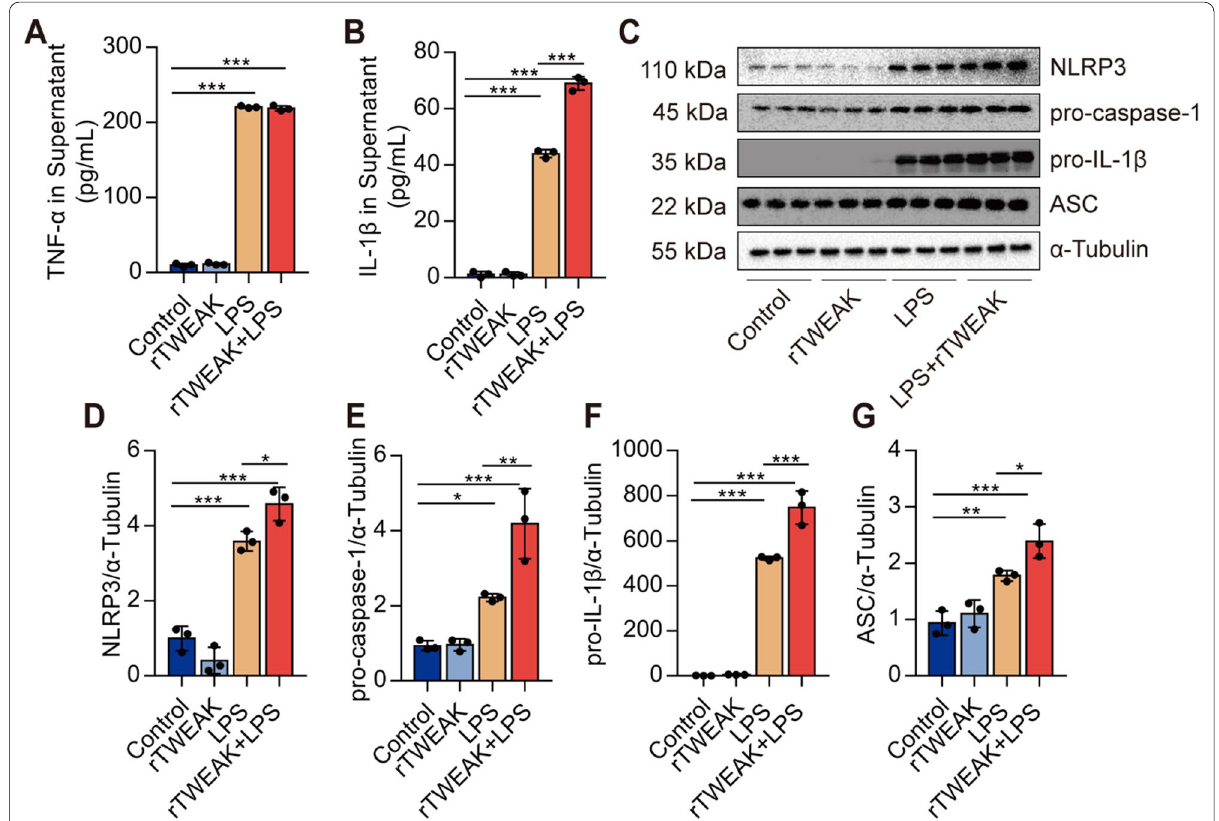
Fig. 6 Activation of Fn14 by rTWEAK promotes the priming of NLRP3 inflammasome in macrophages. rTWEAK (100 ng/mL) was added to LPS (100 ng/mL)‑challenged primary macrophages for 12 h. A , B The contents of TNF‑α and IL‑1β in the supernatant of primary macrophages were determined ( n 3). C – G The expressions of NLRP3, pro‑caspase‑1, pro‑IL‑1β, and ASC protein in primary macrophages were determined by Western = blot ( n 3). Data are expressed as the mean SD. Differences among multiple groups were performed using ANOVA. Tukey’s test was used as a = ± post hoc test to make pair‑wise comparisons. * P < 0.05, ** P < 0.01, and *** P <